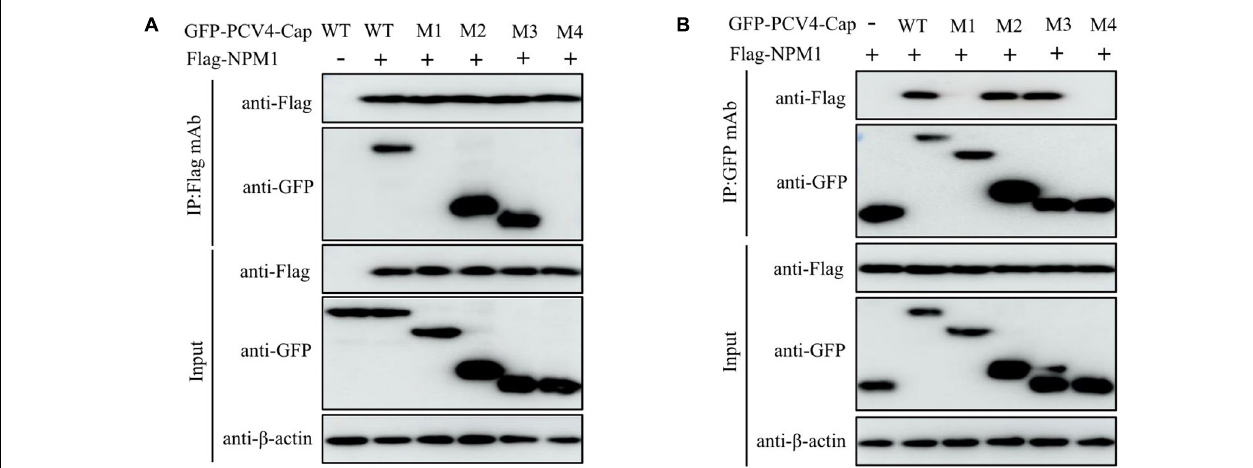
FIGURE 3 | N-terminal residues 1–20 of PCV4 Cap are essential for binding to NPM1. (A,B) HEK293T cells were co-transfected with plasmids containing full-length PCV4 Cap or truncated mutants, together with the Flag-NPM1 plasmid for 48 h; the cell lysate extracts were immunoprecipitated with Flag beads (A) or anti-GFP purified IgG (B) and then detected by western blotting using the indicated